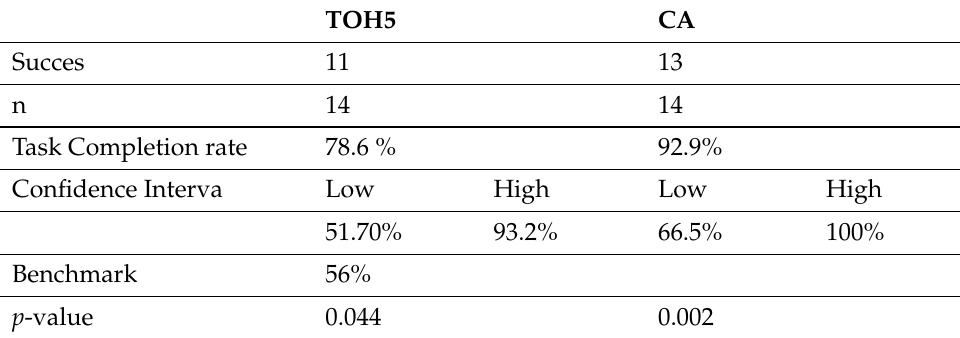
Figure 10. Histogram of fail and pass for tasks AC. Table 7. Statistics Task Completion rate